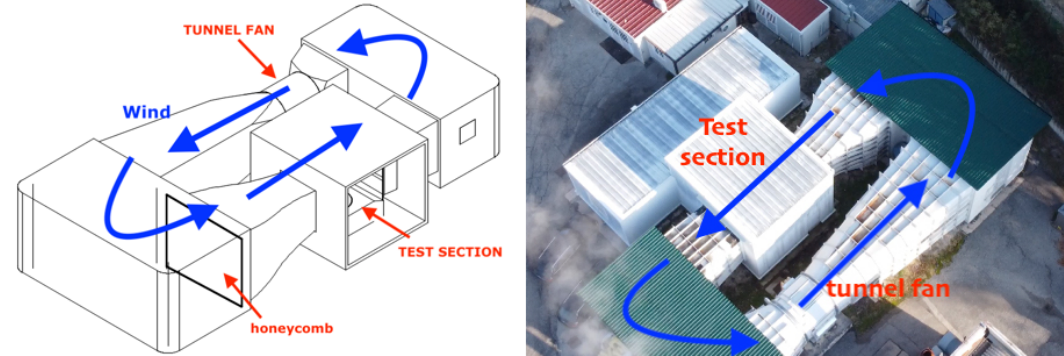
Figure 1. Schematic representation of the wind tunnel “R. Balli” at the University of